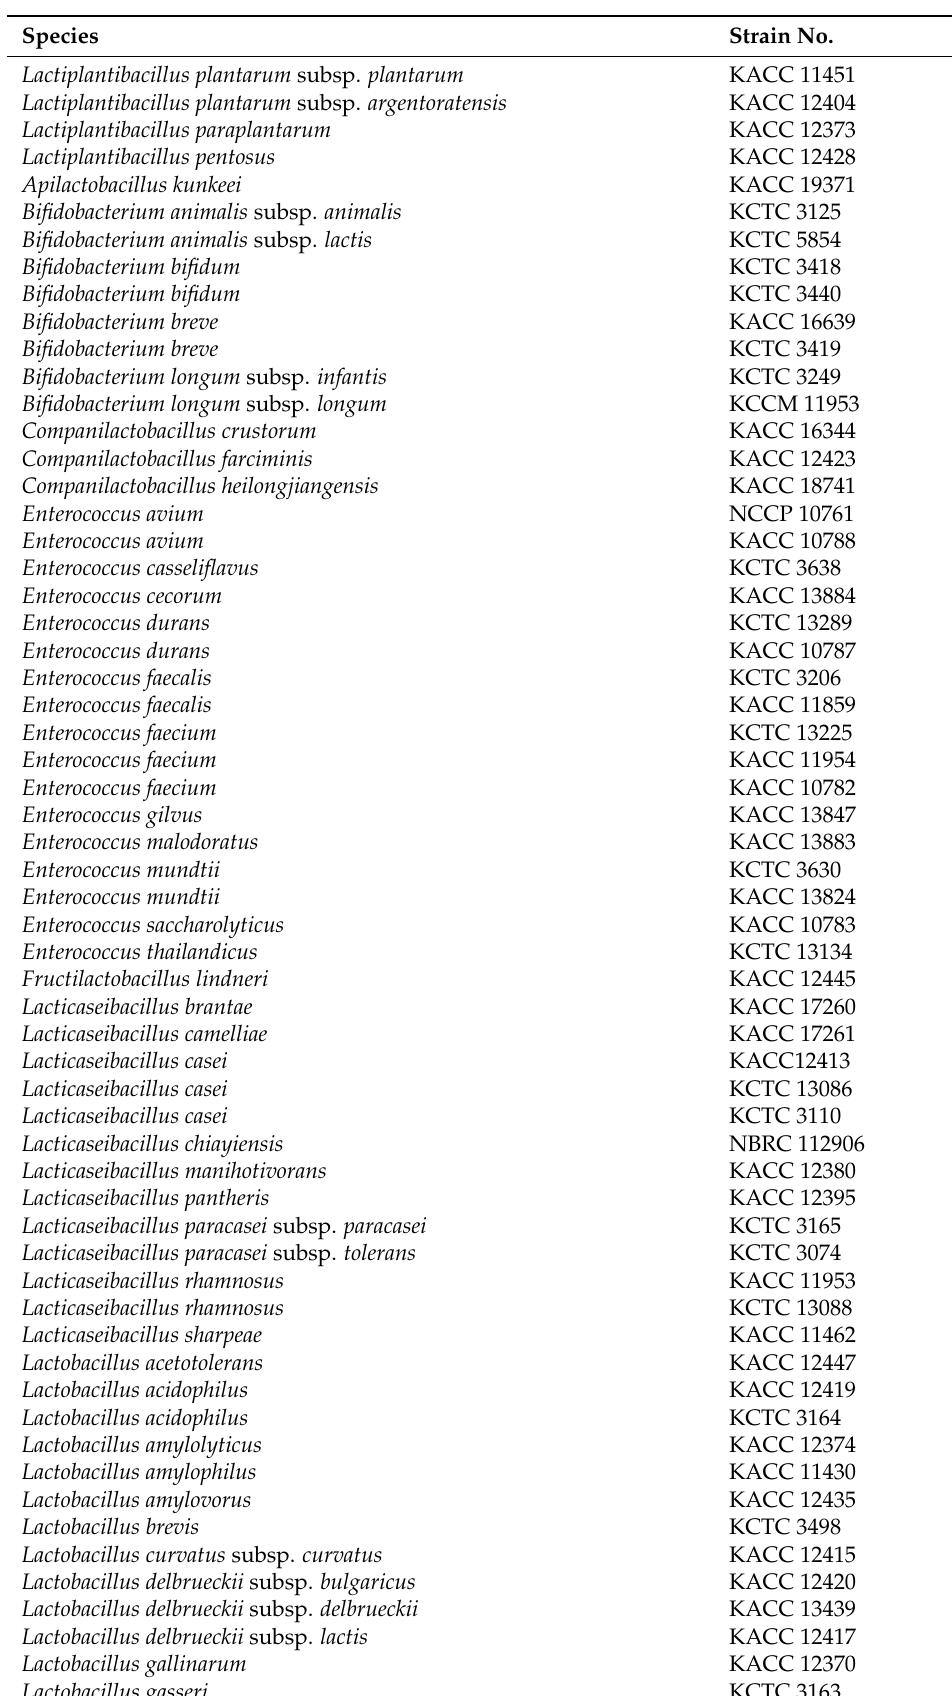
Table 1. List of 105 reference